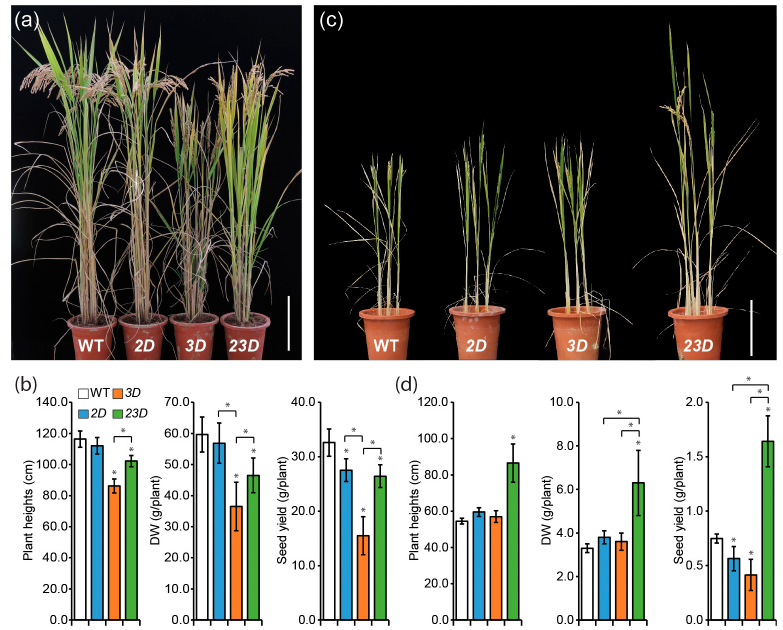
Figure 6. Representative plants of WT, 2D , 3D, and 23D . ( a ) Comparison of WT, 2D , 3D , and 23D plants grown in a paddy field. To take photographs, plants were transferred to pots from paddy fields before harvest. Scale bar = 20cm. ( b ) Plant height, aboveground dry weight (DW), and seed yield of WT, 2D , 3D , and 23D plants grown in a paddy field. Data are means ± SE (n = 4), and significant differences among mutants and WT plants are indicated with an asterisk (* p < 0.05 by Student’s t -test). ( c ) Morphological comparison of WT, 2D , 3D , and 23D plants grown in alkaline soil (pH 8.0) at the reproductive stage. Scale bar = 20 cm. ( d ) Plant height, dry weight (DW), and seed yield of WT, 2D , 3D , and 23D plants grown in alkaline soil (pH 8.0). Data are means ± SE (n = 4), and signi fi cant di ff erences among mutants and WT plants are indicated with an asterisk (* p < 0.05 by Student’s t -test).